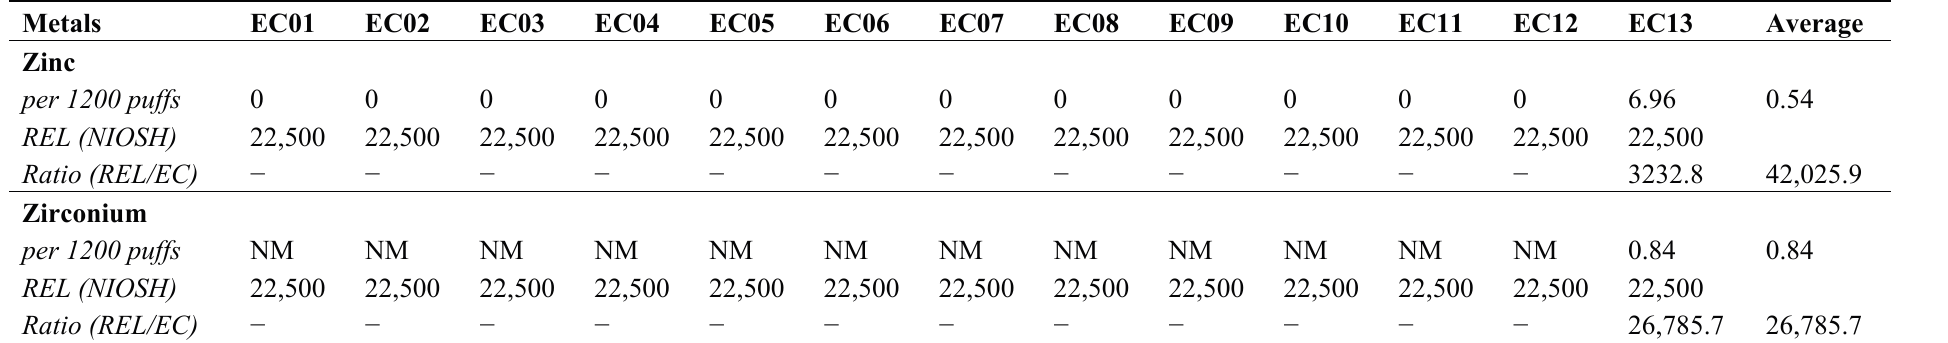
Abbreviations: EC, electronic cigarette; MRL, Minimal Risk Level; ATSDR, Agency for Toxic Substances and Disease Registry; REL, Recommended Exposure Limit; NIOSH, National Institute of Occupational Safety and Health; NM, not measured; a Values for barium nitrate, which has the lowest acceptable exposure limits among any barium salt; b Values for titanium